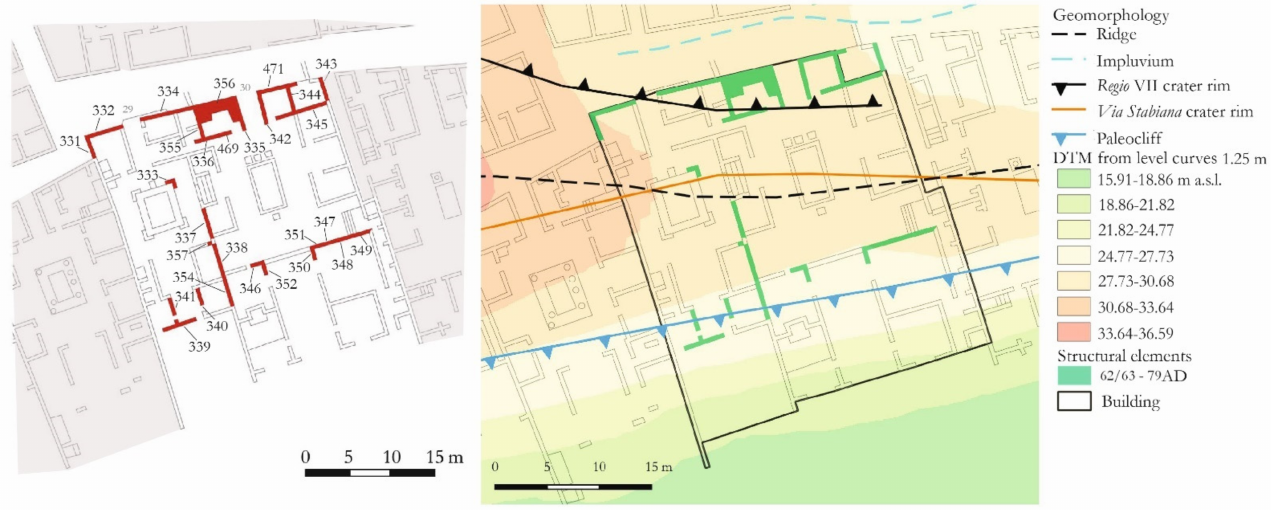
Figure 14. On the left is the plan of House of Francesco Giuseppe (VIII 2, 29–30), with in red the structures built up with NYT elements. On the right, the plan of the topographical factors in the same area (elab. M.